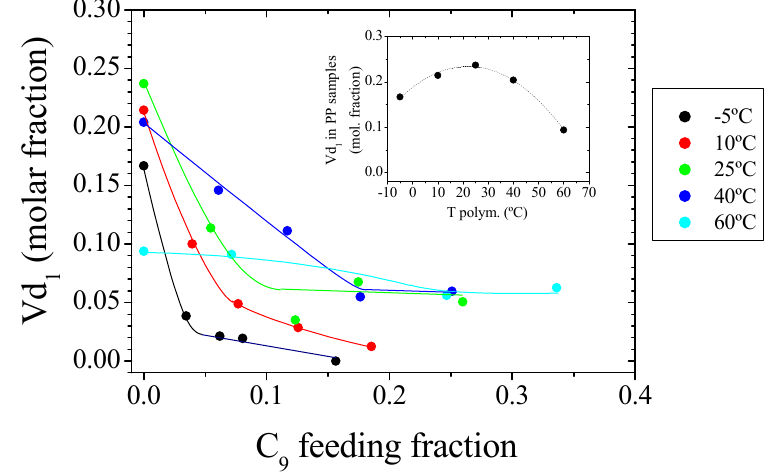
Figure 12. Evolution of Vd 1 content with the C 9 feeding molar fraction for the different series.